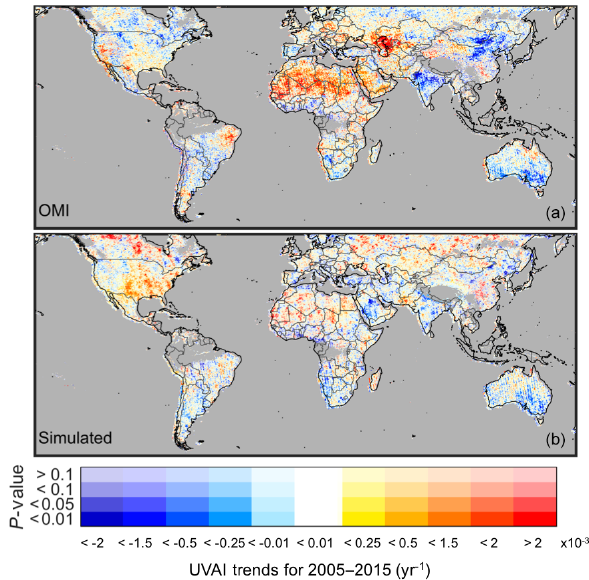
Figure 4. Trends in OMI (a) and simulated (b) UVAI values co- incidently sampled from OMI calculated from the generalized least squares regression of monthly time series values during 2005–2015. The opacity of the colours indicates the statistical significance of the trend. Grey indicates persistent cloud fraction greater than